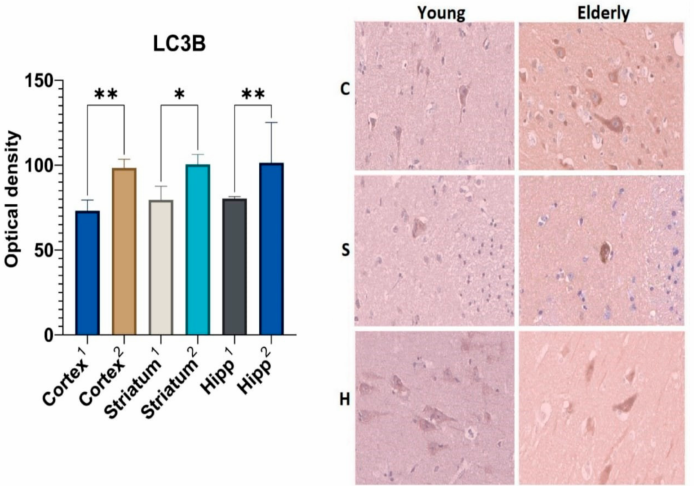
Figure 4. Results of LC3B immunohistochemical staining: 1—young group, 2—elderly group; C—cortex, S—corpus striatum, H—hippocampus. *—differences are statistically significant ( p < 0.05). **—differences are statistically significant ( p < 0.001). Magnification 400 × .